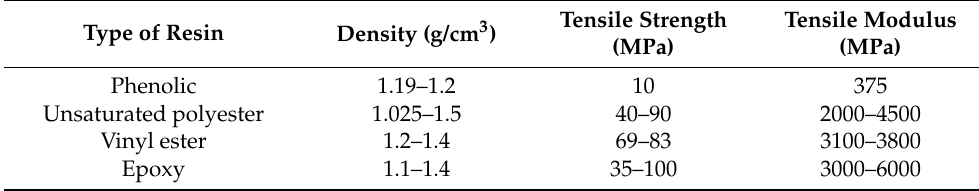
Figure 2. Schematic overview of conventional thermoset composite waste processing and recycling routes [33]. Table 2. Properties of thermosetting resin [34].